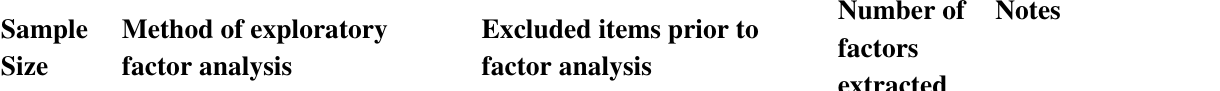
Table 1. Summary of studies identified in the systematic review that had conducted an item-level factor analysis on their own dataset. Listed are the type of sample, the sample size, the method of factor analysis used, and whether items had been excluded from the factor analysis. The number of factors extracted is also listed for each study. Unless otherwise stated in the notes, an English language version of the Brief COPE [1] was